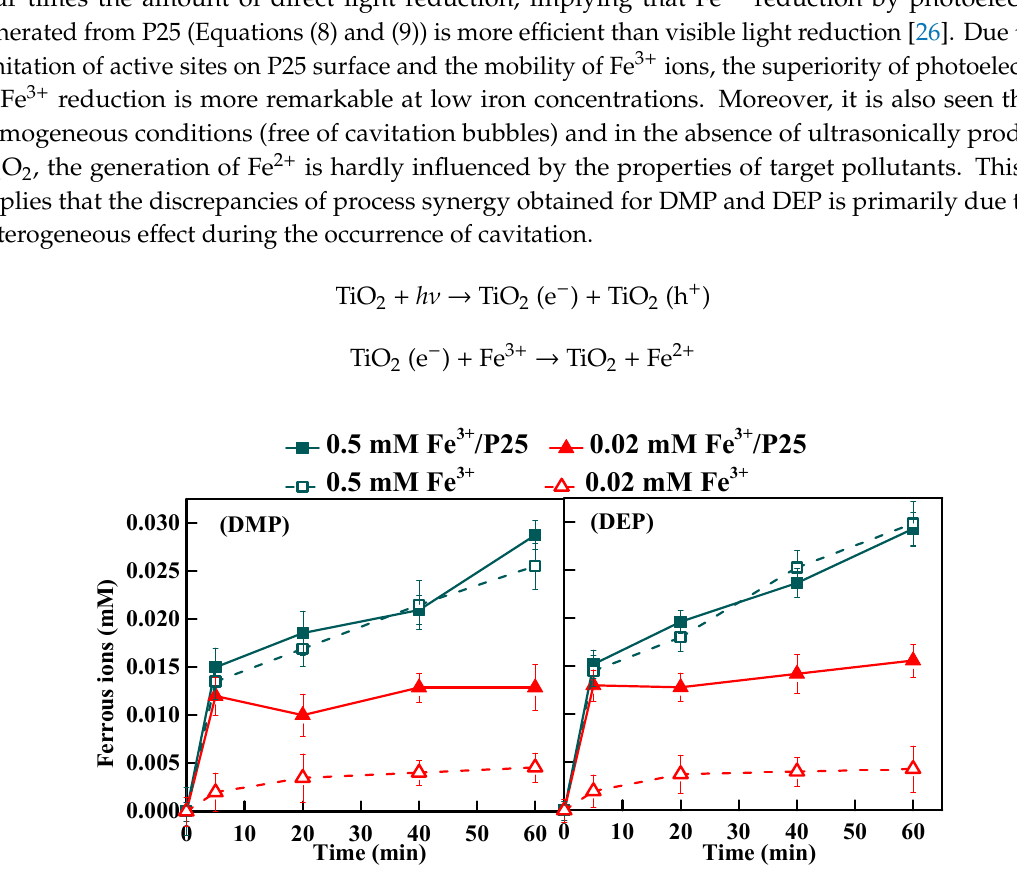
Figure 4. The reduction of ferric iron under visible light irradiation with and without the presence of P25 ([DMP] 0 = 0.01 mM, [DEP] 0 = 0.01 mM, P25 0.5 g L −1 ).